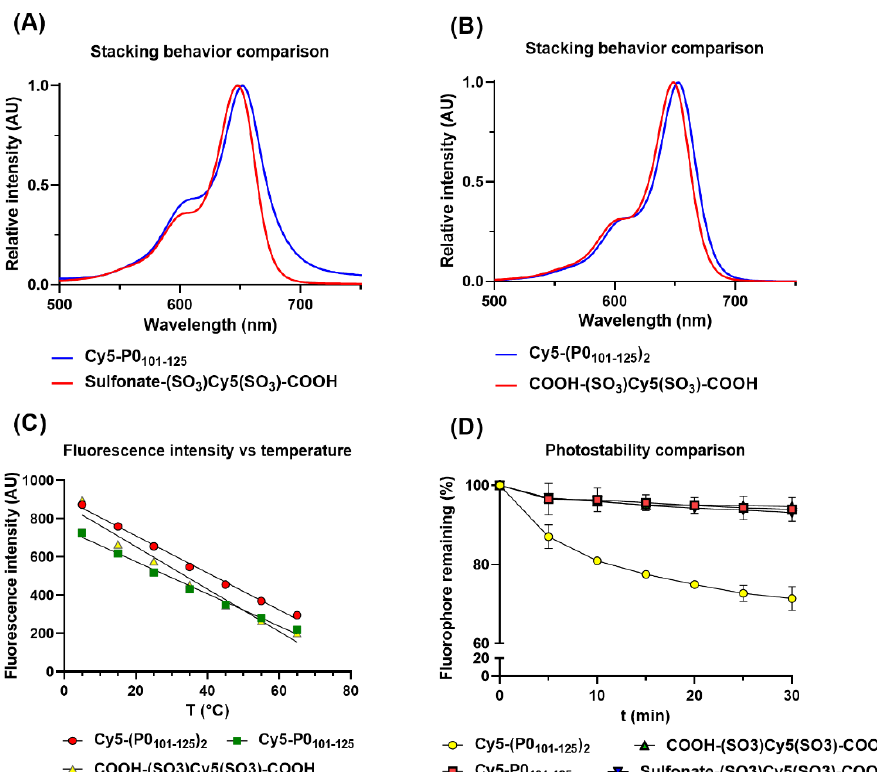
Figure 2. Photophysical properties of Cy5-P0 101–125 and Cy5-(P0 101–125 ) 2 . ( A ) Comparison in stacking behavior between Cy5-P0 101–125 and corresponding free sulfonate-(SO3)Cy5((SO3)-COOH dye at 8mM measured in water. ( B ) Comparison in stacking behavior between Cy5-(P0 101–125 ) 2 and corre- sponding free COOH-(SO 3 )Cy5(SO 3 )-COOH dye at 8 mM measured in water; each spectrum was normalized at its wavelength of maximum absorbance. ( C ) Fluorescence intensity dependence of the tem- perature for Cy5-P0 101–125 , Cy5-(P0 101–125 ) 2 and symmetrical free dye COOH-(SO3)Cy5((SO3)-COOH; a trendline is included for all compounds. (D) The optical stability of Cy5-(P0 101–125 ) 2 , Cy5-P0 101–125 , and of corresponding free dyes determined over the course of 30 min (means were fitted).